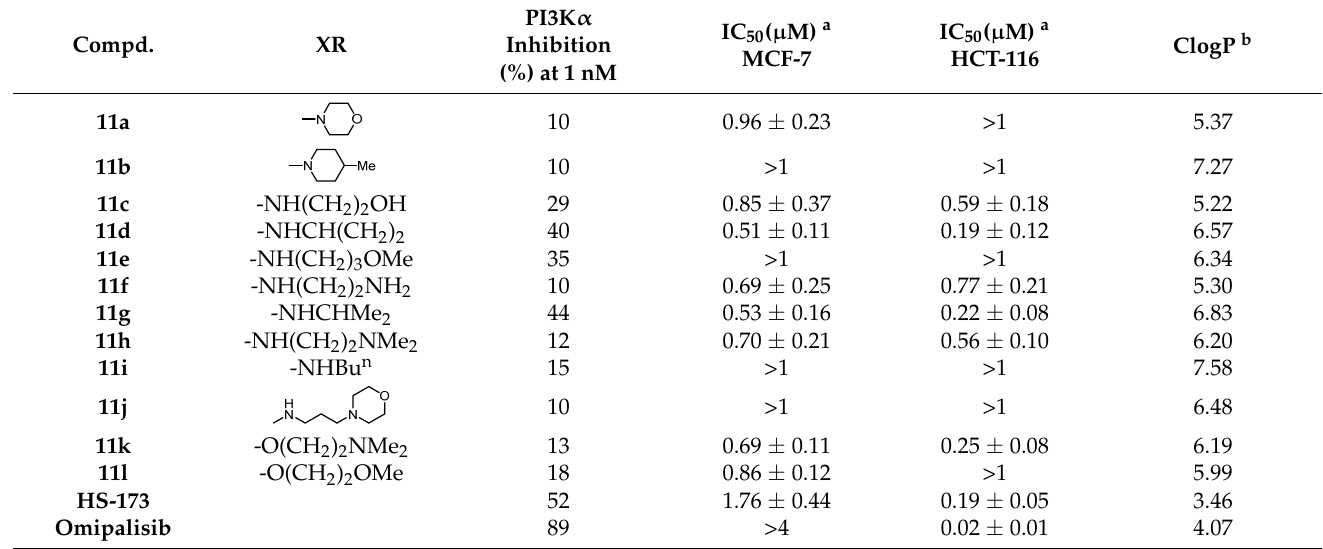
Table 1. Enzyme inhibition of PI3K α and antiproliferative activity against MCF-7 and HCT-116 cells by 11a–l .